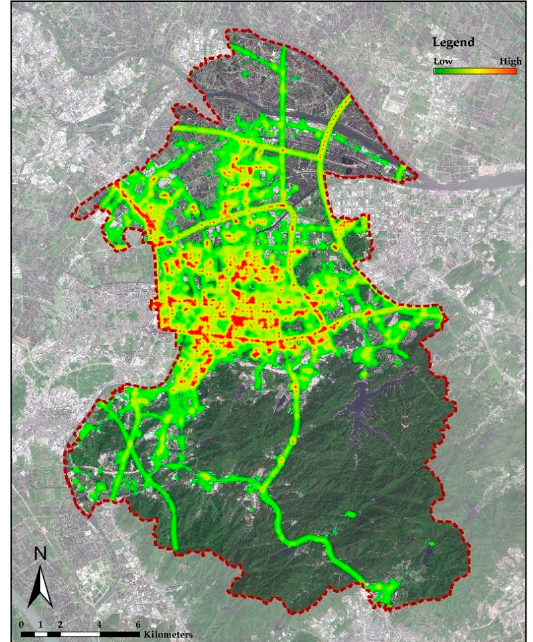
Figure 12. Overall public vitality in the study area.